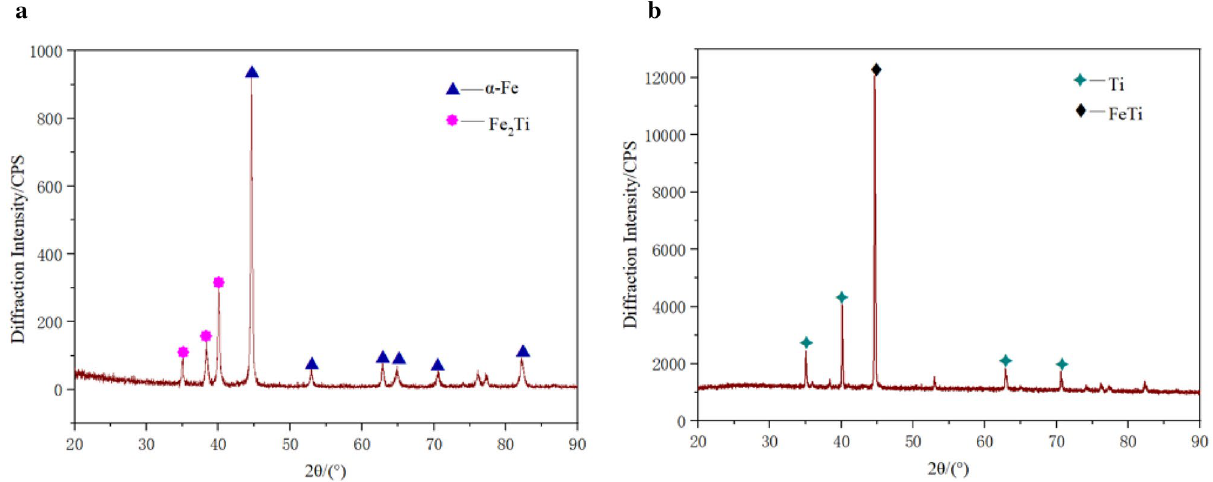
Figure 5. X-ray diffraction pattern of the selected areas in joint: (a) close to the base layer (Q235). (b) Close to the base layer